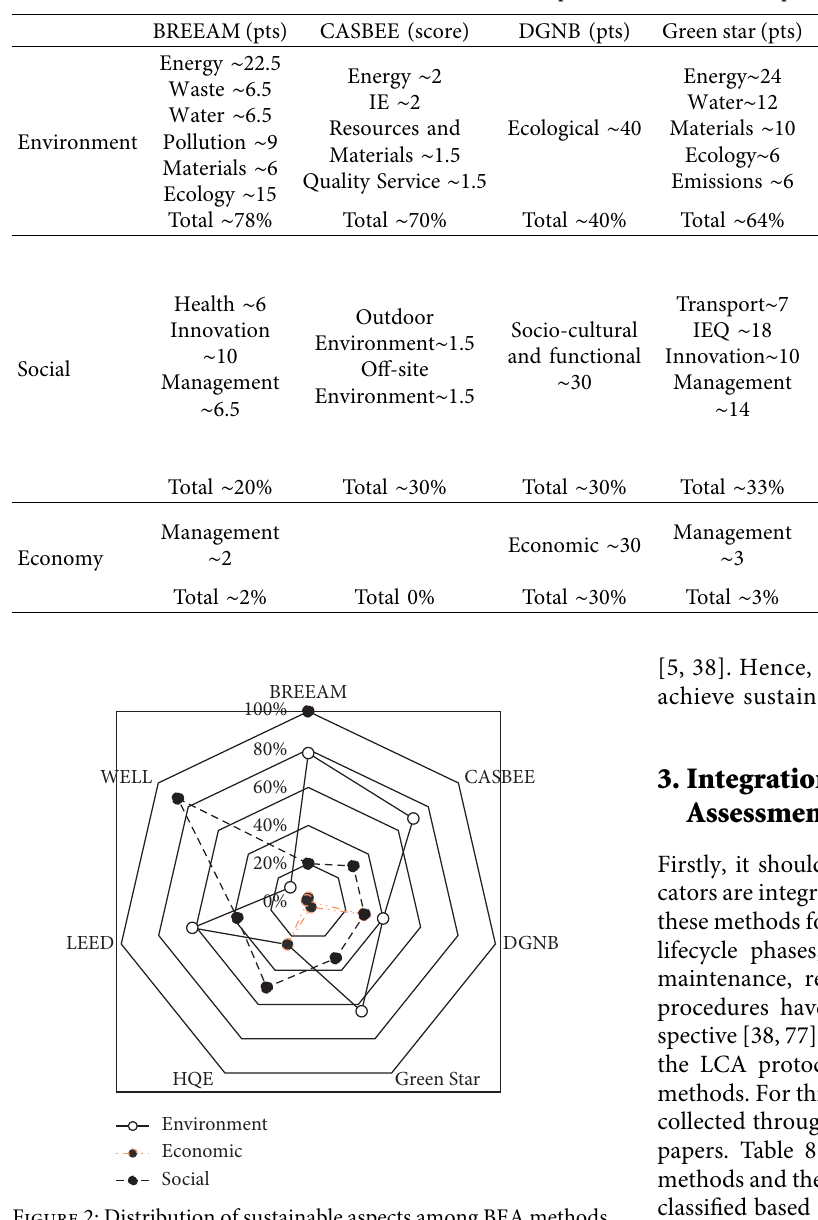
Table 7: Distribution of credit points for sustainable aspects by categories [43].